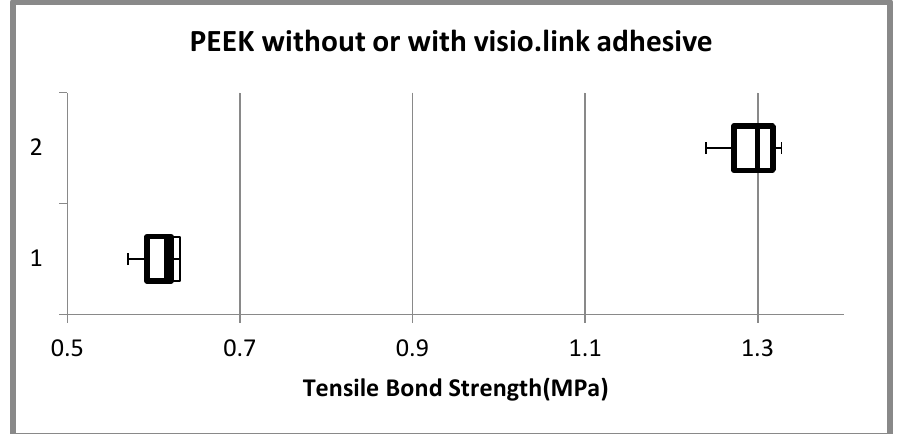
Figure 8. Comparison of mean tensile bond strength of poly ether ether ketone (PEEK) with and without visio.link adhesive. Vertical Axis: 1—PEEK without Visio.link adhesive, 2—PEEK with Visio.link adhesive. Table 1. Particulars for mean tensile bond strength of PEEK with and without visio.link adhesive.